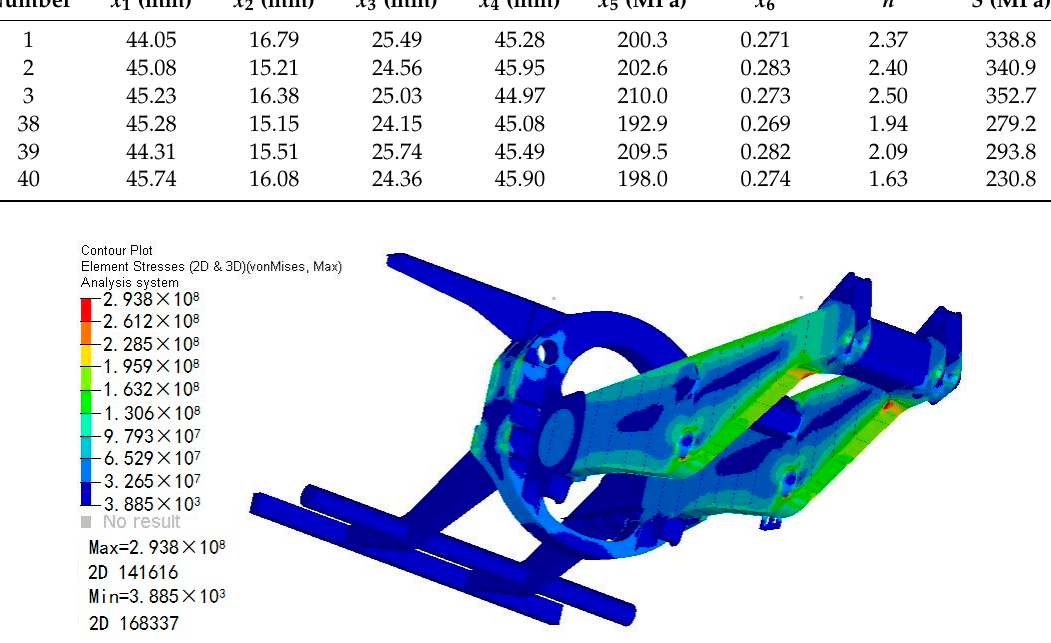
Figure 4. Contour of vonMises stress under bending due to horizontal loading (unit: MPa). Table 6. Sample data and corresponding responses.